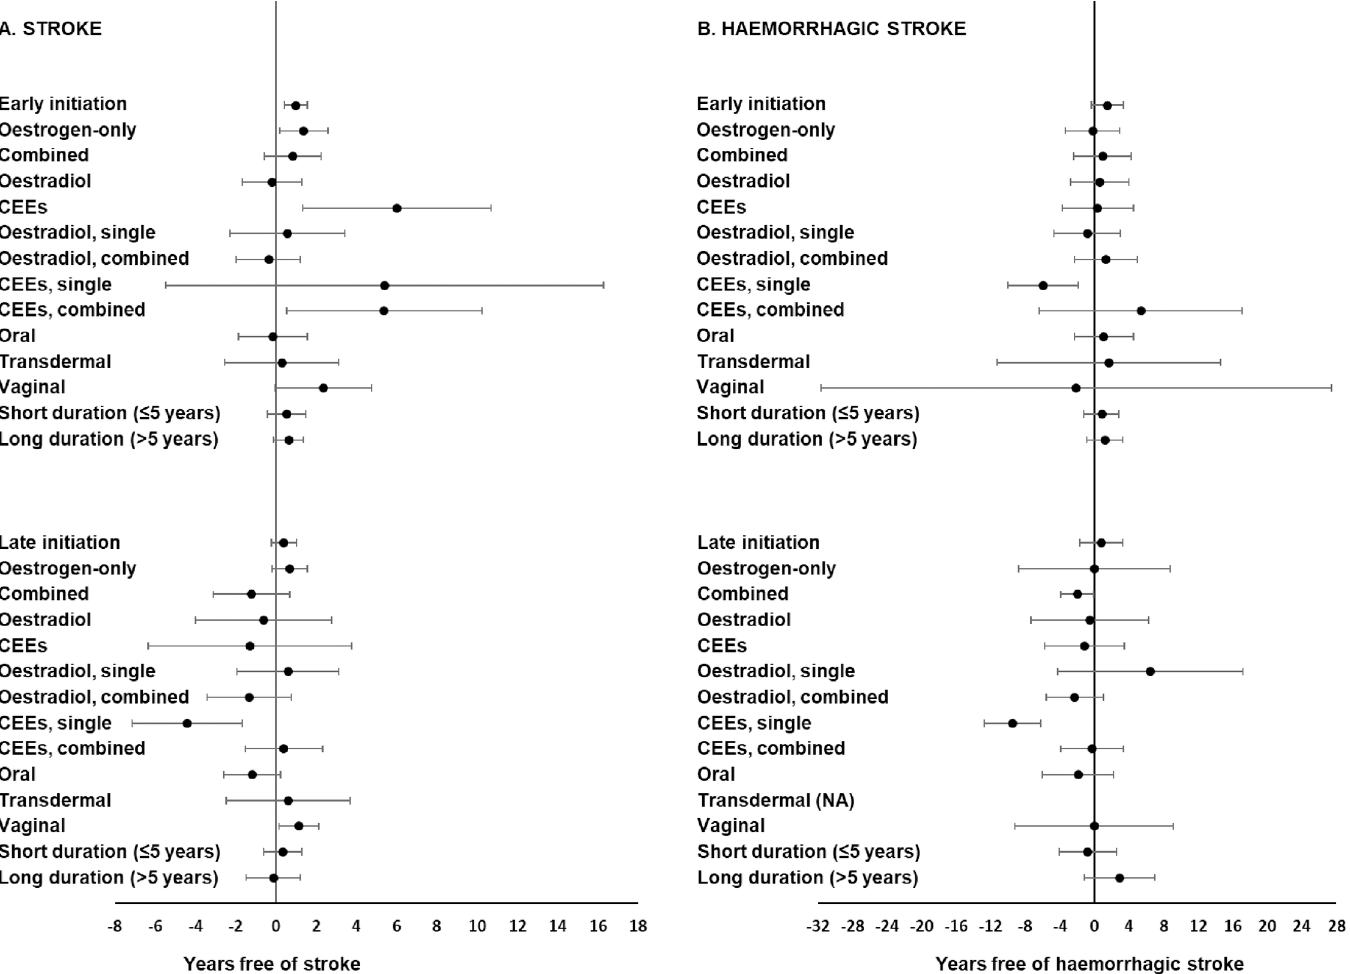
Fig 1. Associations between multivariable-adjusted stroke-free (A) and haemorrhagic stroke-free (B) periods (percentile differences) and various categories of postmenopausal hormone therapy (HT) by timing of initiation using a 5-year cutoff. The reference group is never use. The adjusted models includedage at baseline, level of education(primary school, high school, or university), smoking status (never, former, or current), body mass index ( < 25, 25–29,or (cid:21) 30 kg/m 2 ), level of physicalactivity (low, moderate,or high), and age at menopauseonset (41–46,47–52, or 53–58 years). The fifth and first percentiledifferences with 95% confidenceintervalswere calculatedfor stroke and haemorrhagic stroke, respectively.Note that the scale of the x-axis is different for stroke and haemorrhagic stroke. CEE, conjugated equineoestrogen;NA, not applicable, due to 0 haemorrhagic stroke cases among users of transdermal